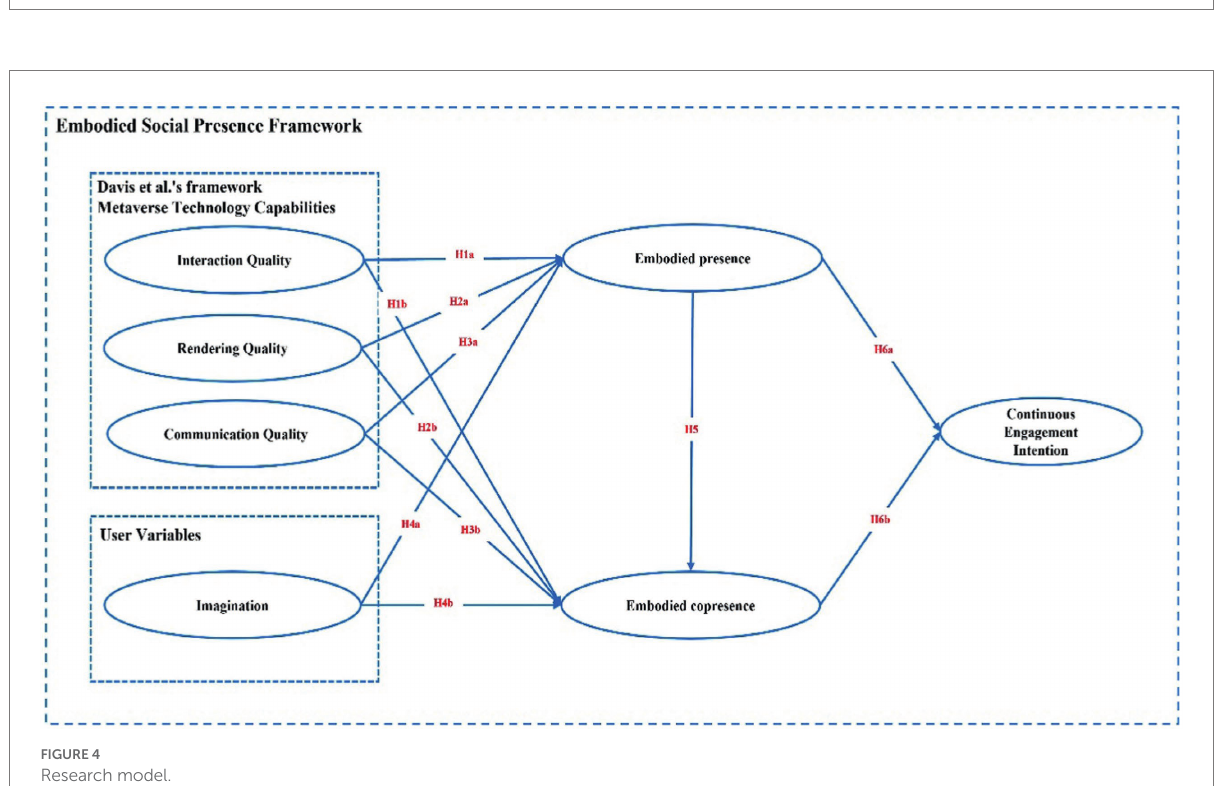
FIGURE 4 Research